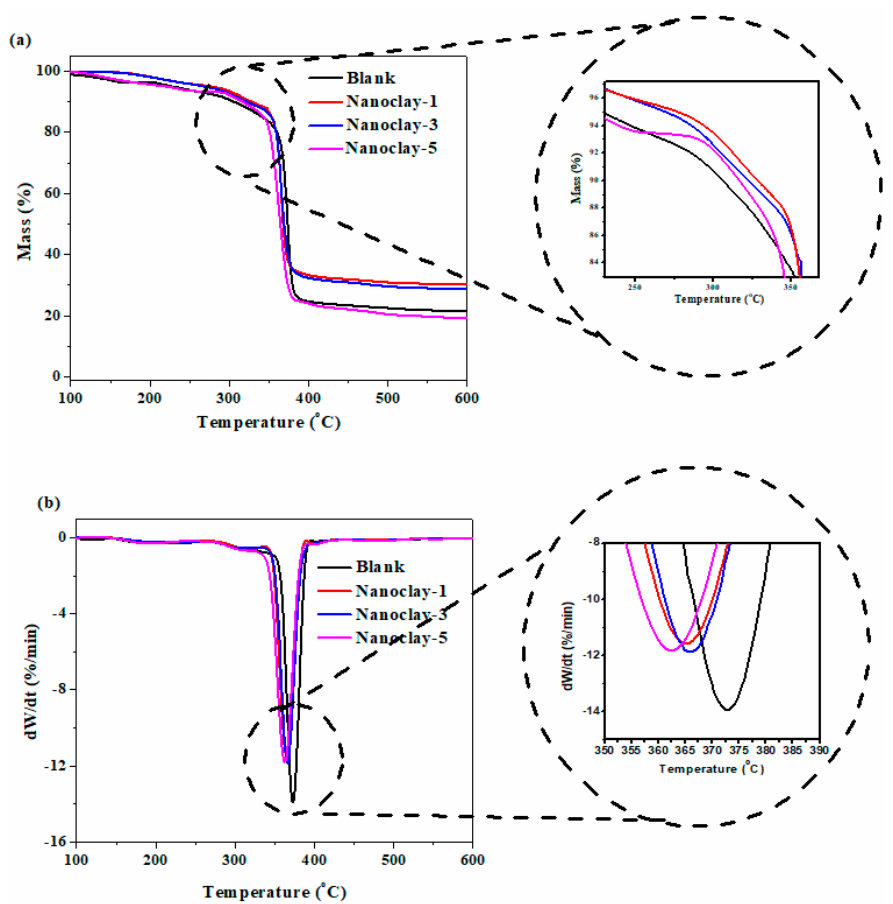
Figure 2. ( a ) TGA and ( b ) DTG thermograms of PU / Clay nanocomposites at β = 5 ◦ C / Figure 2. TGA and DTG thermograms of PU/Clay nanocomposites at β = 5 °C/min. Table 1. Thermal decomposition characteristics of PU/Clay nanocomposites derived from TGA diagrams at β = 5 °C/min.